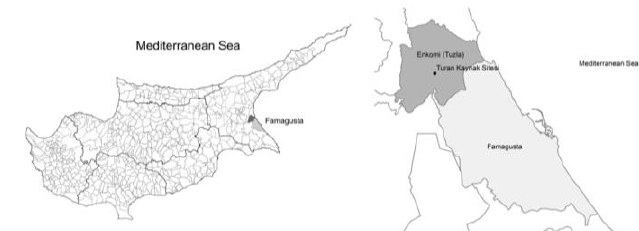
Figure 1. Cyprus Map, location of Famagusta city and “Turan Kaynak Sitesi” at proximity of Enkomi (GIS developed by